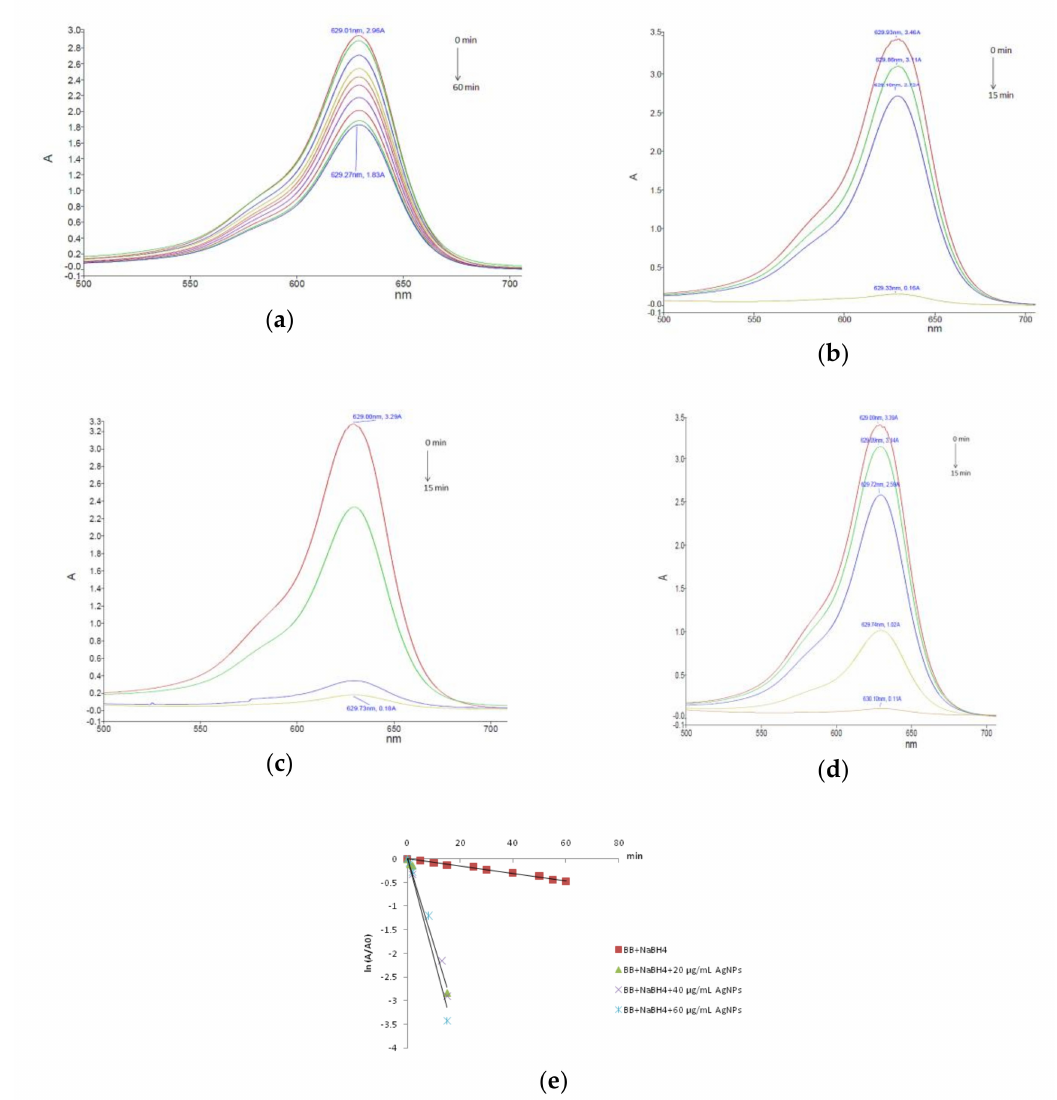
Figure 9. NaBH 4 mediated brilliant blue FCF degradation: ( a ) without a catalyst; ( b ) in the presence of 20 µ g / mL AgNPs; ( c ) in the presence of 40 µ g / mL AgNPs; ( d ) in the presence of 60 µ g / mL AgNPs and ( e ) kinetics